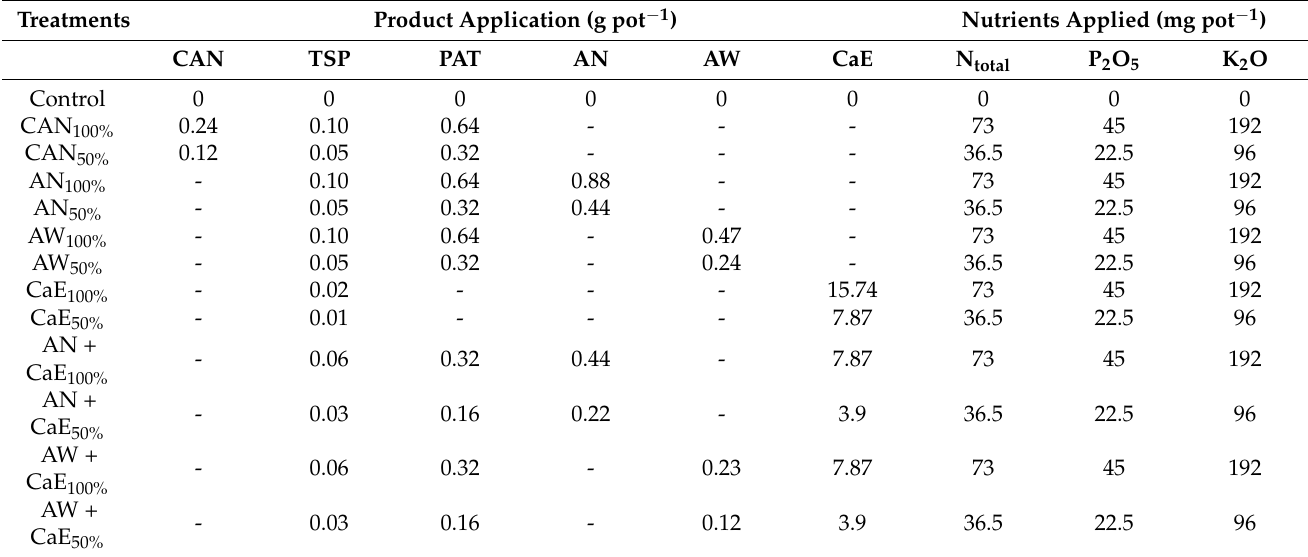
Table 2. Application rates of products (g pot − 1 ) and macronutrients (mg pot − 1 ) in the pots as per recommended nutrient